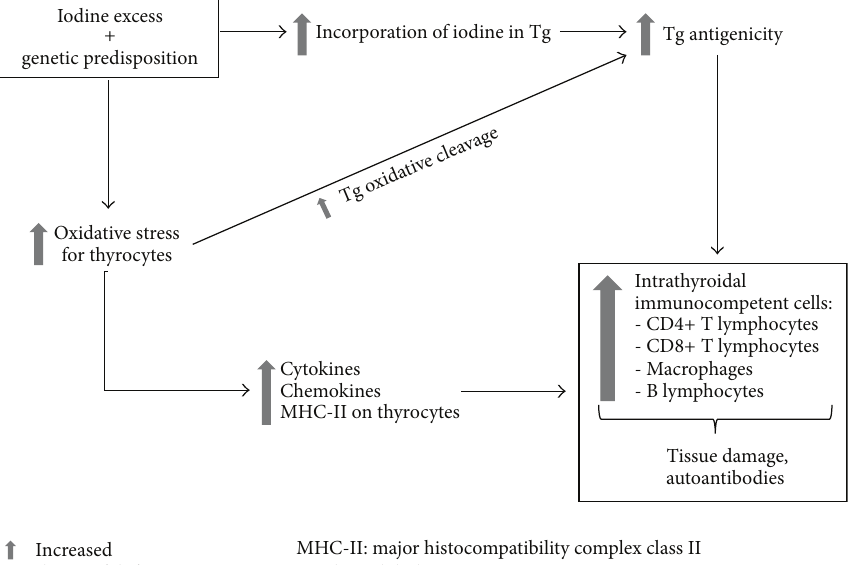
Figure 1: Iodine “excess” and thyroid autoimmunity. Iodine can damage thyrocytes directly, through intracellular oxidative stress, and indirectly, through activation of proinflammatory phenomena that recruit immunocompetent